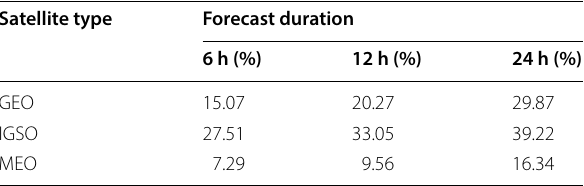
Table 4 Model improvement rate of Semi-K model relative to QP model Satellite